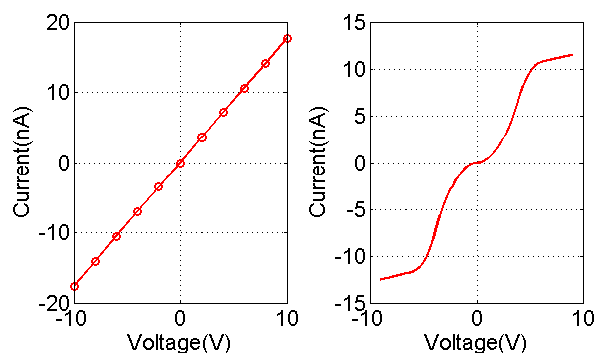
Figure 2. I-V characteristics of device A ( left ) and device B ( right ).